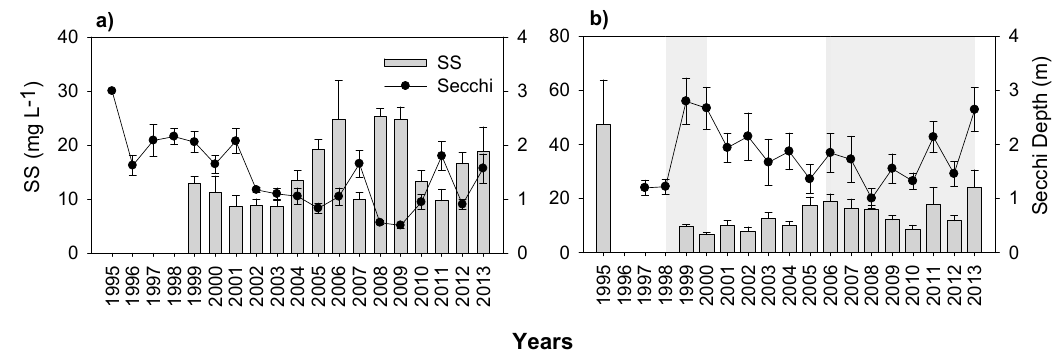
Figure 5. Changes in yearly mean (with ± SE) water transparency (Secchi depth) and concentrations of suspended solids (SS) from 1995 to 2013 for ( a ) Lake Mogan and ( b ) Lake Eymir (shaded periods indicate the first and second biomanipulations). Note the scale differences on the y ‐ axes.